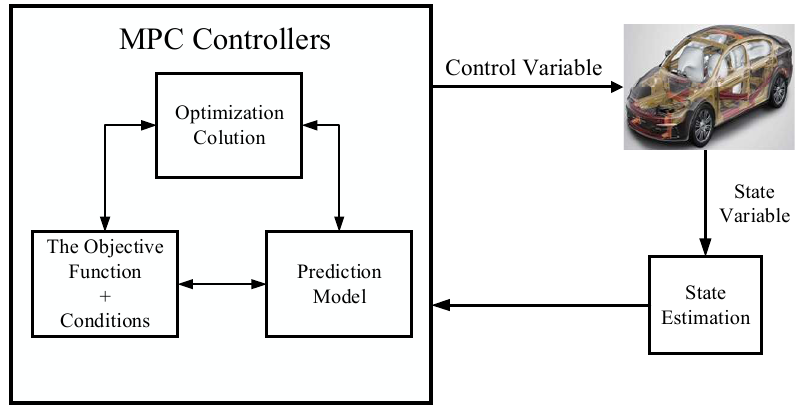
Figure 3. Schematic diagram of MPC